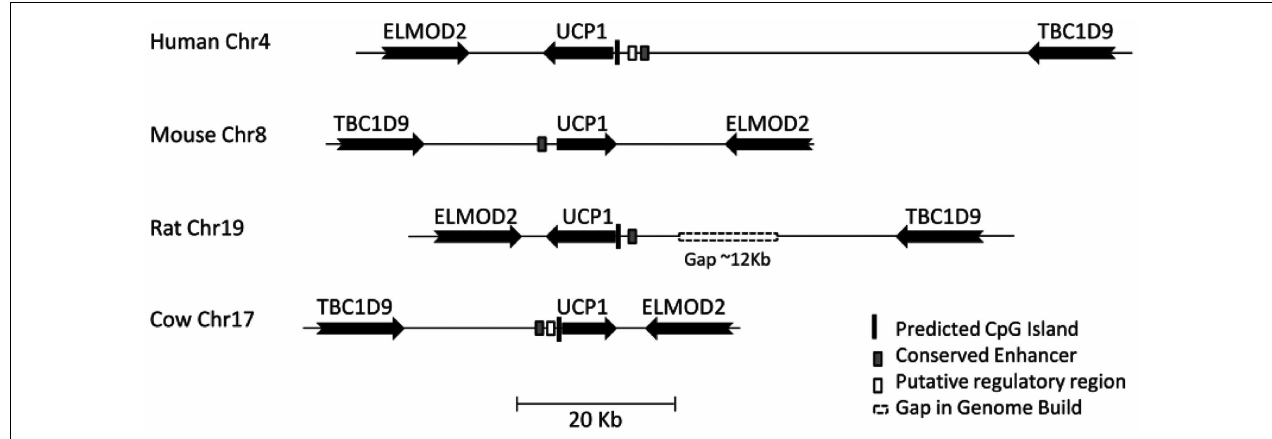
FIGUREA1 | Gene synteny around the UCP1 locus. Relative positions of UCP1 orthologs in four representative species showing conservation of synteny. Positions of conserved upstream regions and predicted CpG islands are shown. Gaps in current genome build are shown as hashed boxes. For details see